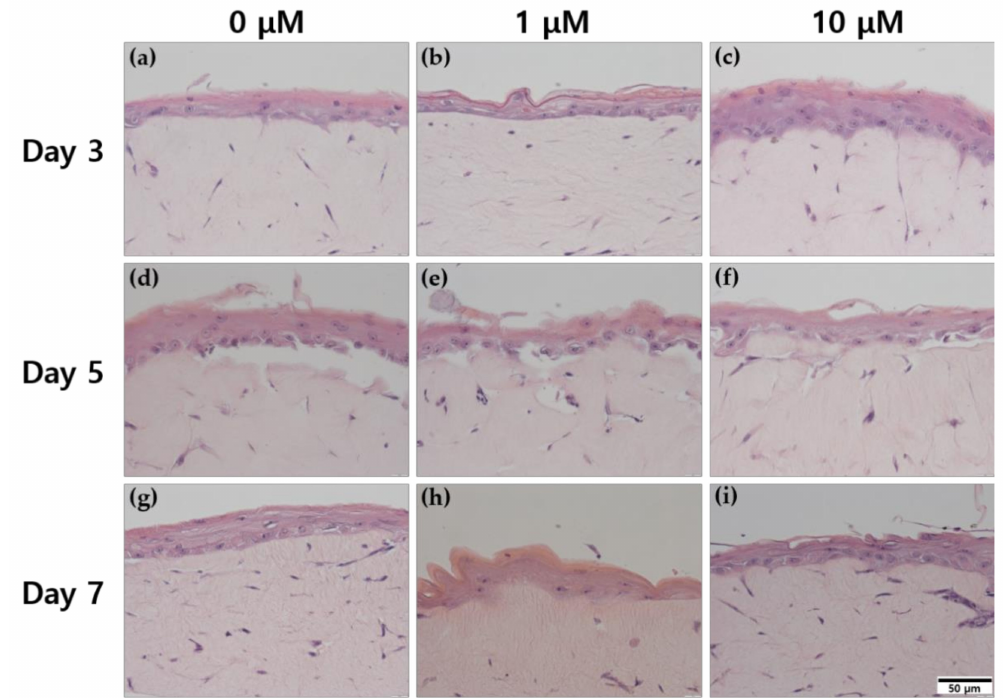
Figure 2. Hematoxylin and eosin staining (H&E) images of human skin equivalents (HSEs) for 3 days air exposure culture treated α -lipoic acid concentration of ( a ) 0 µ M, ( b ) 1 µ M, and ( c ) 10 µ M. For 5 days, air exposure culture treated α -lipoic acid concentration of ( d ) 0 µ M, ( e ) 1 µ M, and ( f ) 10 µ M. Seven days air exposure culture treated α -lipoic acid concentration of ( g ) 0 µ M, ( h ) 1 µ M, and ( i ) 10 µ M. The results were taken at 40 magnification (Scale bar = 50 µ